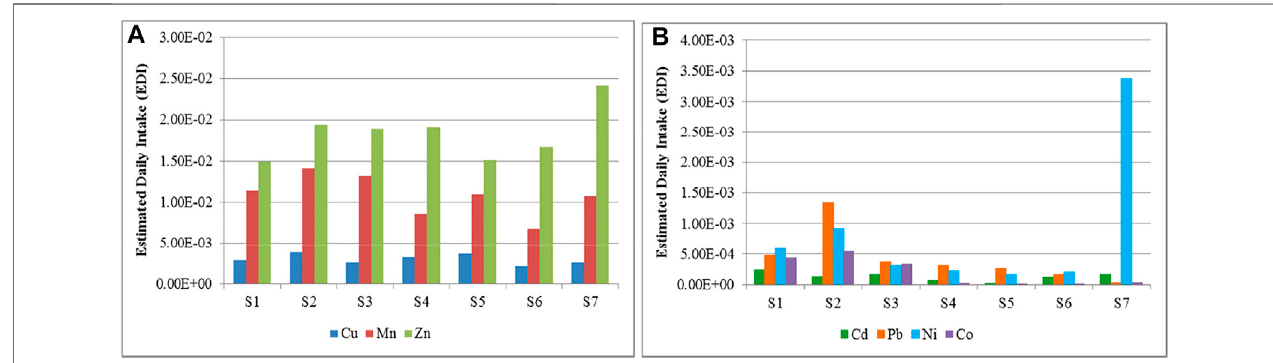
FIGURE 4 | (A,B) EDI of heavy metals in coriander at different sampling sites.